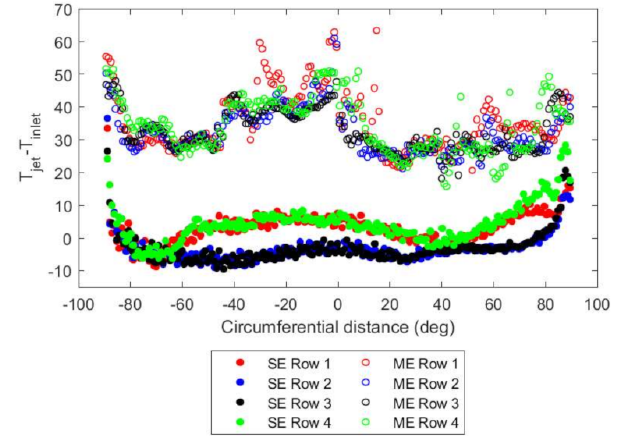
Figure 10. Circumferential distribution of increase in static temperature across all four arrays of holes for both single–entry and multiple–entry cases at 100% mass flow rate condition.